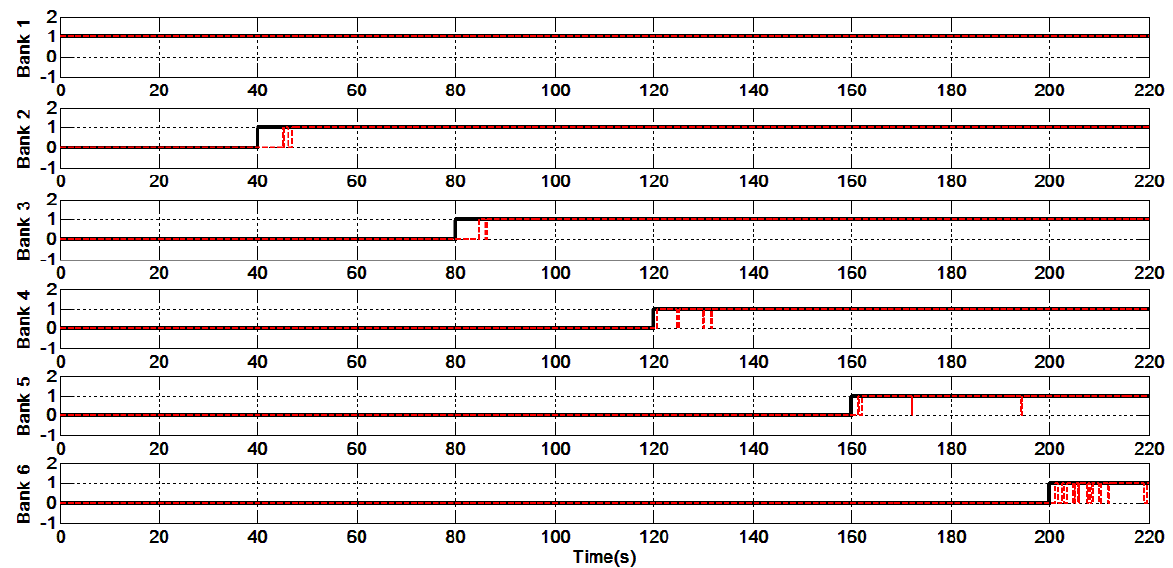
Figure 14. Generated power and pitch angle under PI fluctuation